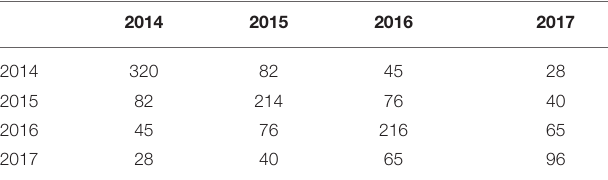
TABLE 2 | Variety connectivity matrix across years: diagonal elements are numbers of varieties grown in individual years; off-diagonal elements are numbers in common between pairs of